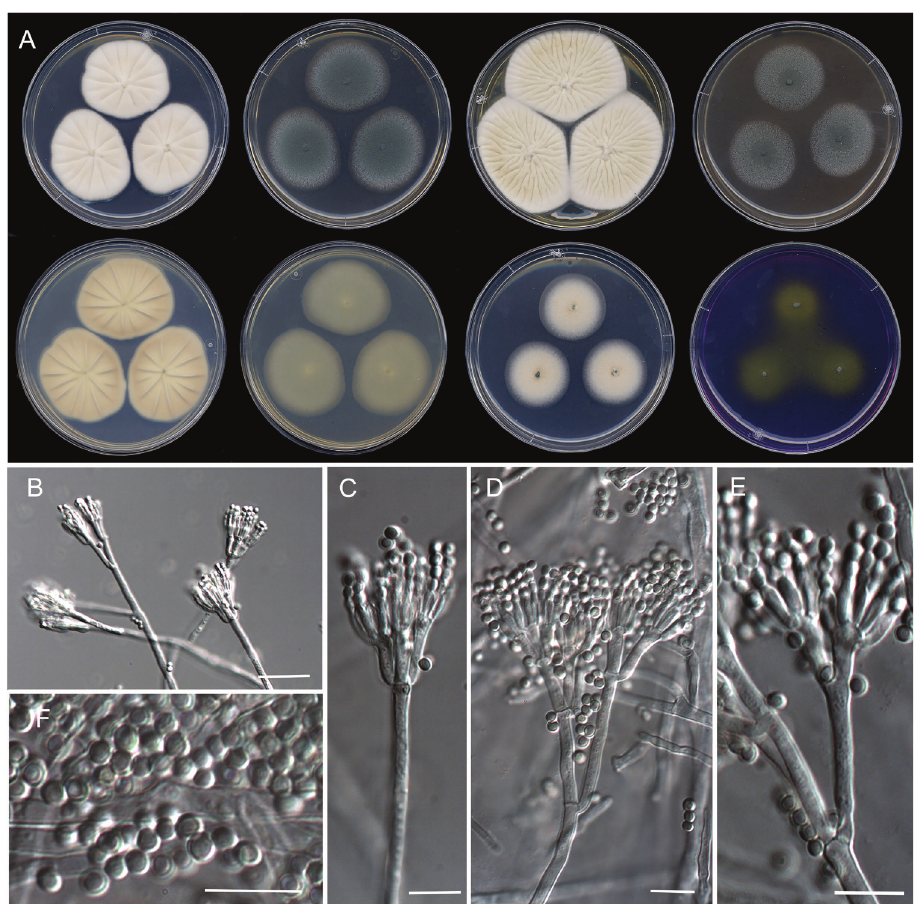
Figure 15. Morphological characters of Penicillium tardochrysogenum (FMR 17137). A colonies from left to right (top row) CYA, MEA, YES, and OA; (bottom row) CYA reverse, MEA reverse, DG18, and CREA B–E conidiophores on MEA F conidia. Scale Bars: 25 μm ( B ), 10 μm ( C–F reverse amber yellow (4B6) at center to maize (yellow) (4A5) towards periphery; soluble pigment absent. On OA, 35–37 mm diam., flattened, velvety, dark green (28F8) at center to greenish gray (28D4) and white (1A1) towards periphery, margins low and entire, sporulation abundant, conidial masses dull green (25D3); reverse honey yellow (4D6) at center and sand yellow (4B3) towards periphery; soluble pigment absent. On DG18, 30– 32 mm diam., flattened, floccose, dark green (27F8) at center to pale orange (5A3) and white (1A1) towards periphery, margins low and entire, sporulation abundant, conidial masses grayish green (28C3) at the center; reverse wax yellow (3B5) at center to white (1A1) towards periphery; soluble pigment absent. On CREA, 24–25 mm diam., flattened, floccose, jade green (27E5) at center to yellowish green (30B8) towards periphery, margins slightly fimbriate, sporulation sparse, conidial masses grayish green (27C3–C4); reverse yellowish white (30B8), soluble pigment absent and acid production moderately strong.